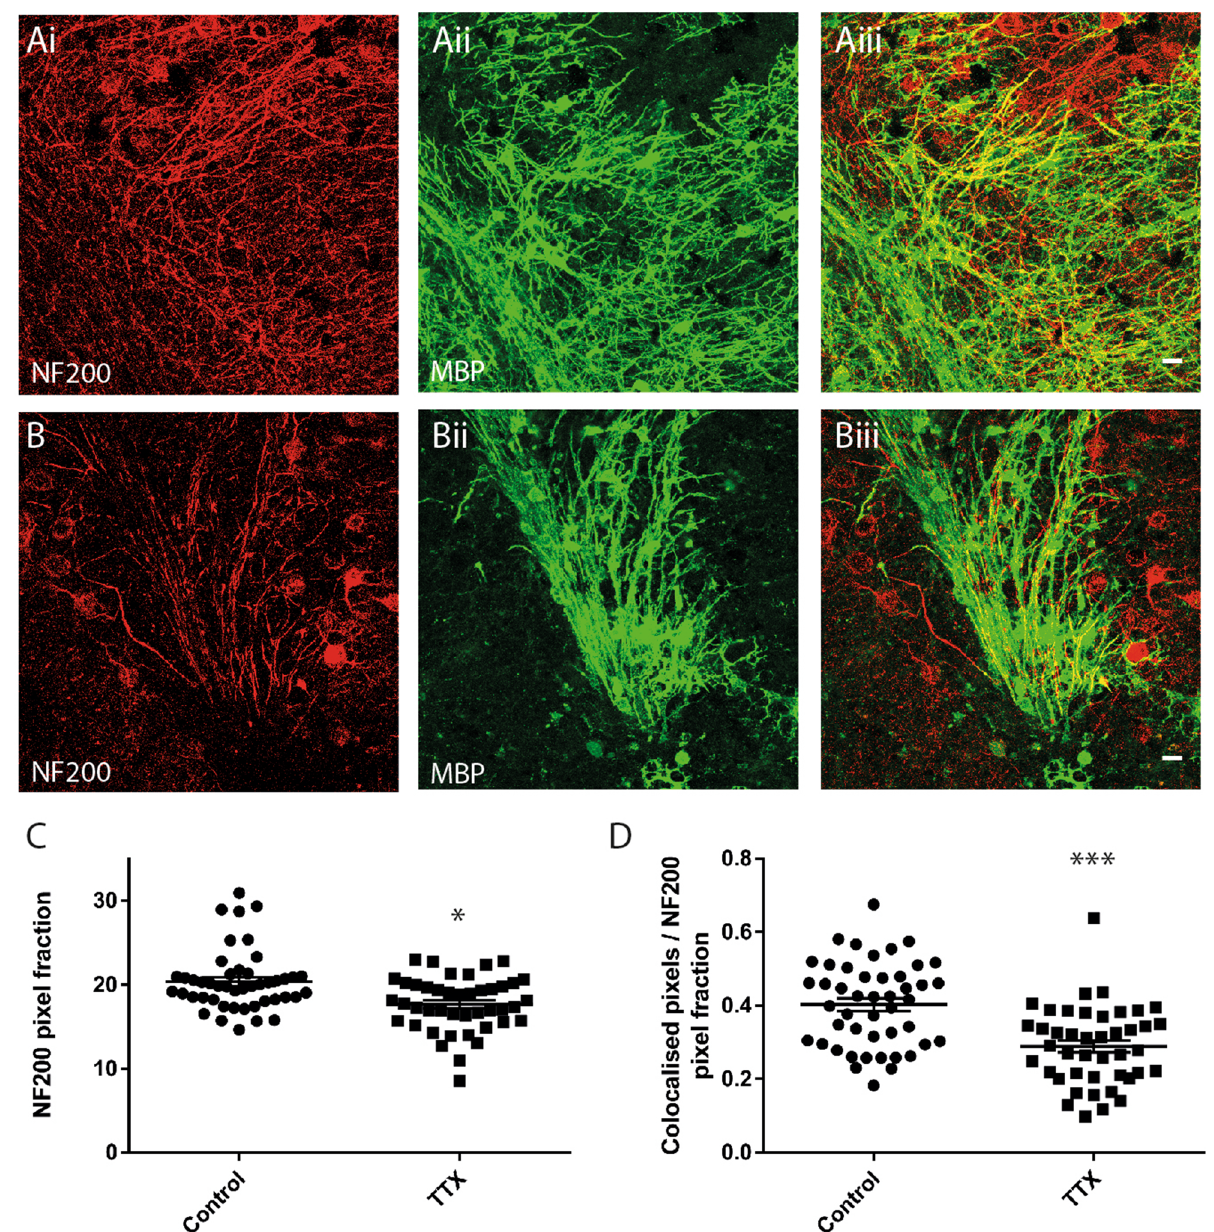
Figure 5. Sustained inhibition of neuronal activity reduces myelination of cerebellar white matter. ( A , B ) Maximum projection images from representative control ( A ) and TTX ( B ) treated cerebellar slices showing immunofluorescent signals for anti-NF200 ( Ai , Bi ) anti-MBP ( Aii , Bii ), and co-localisations used to quantify myelination ( Aiii , Biii ). ( C ) Quantification of anti-NF200 signals. Mean NF200 pixel fraction is reduced by TTX (Control 20.4 ± 0.5, TTX 17.7 ± 0.5. ( D ) Average MBP/NF200 ratios normalized against the NF200 signal are significantly reduced by TTX (Control 0.4 ± 0.02, TTX 0.29 ± 0.02). Scale bars in ( A ) and ( B ) 20 µm. * and *** Significance P < 0.05 and P < 0.001, respectively. Data expressed as means ±